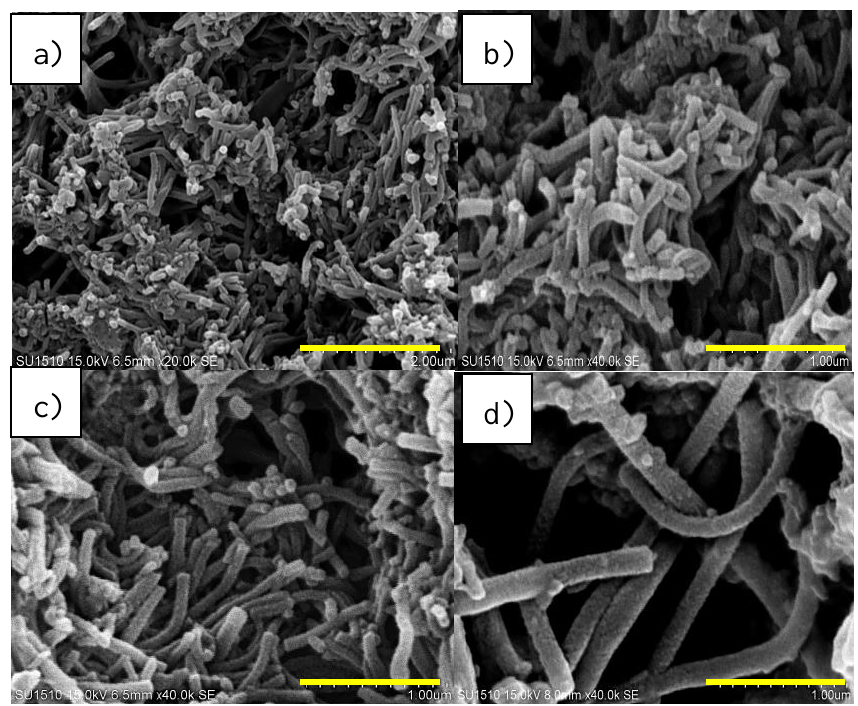
Figure 2. SEM images of PANI nanofibers at different wt% of PMVEA to aniline ( a ) 0.5 wt %; ( b ) 1 wt %; ( c ) 3 wt % and ( d ) 6 wt %.